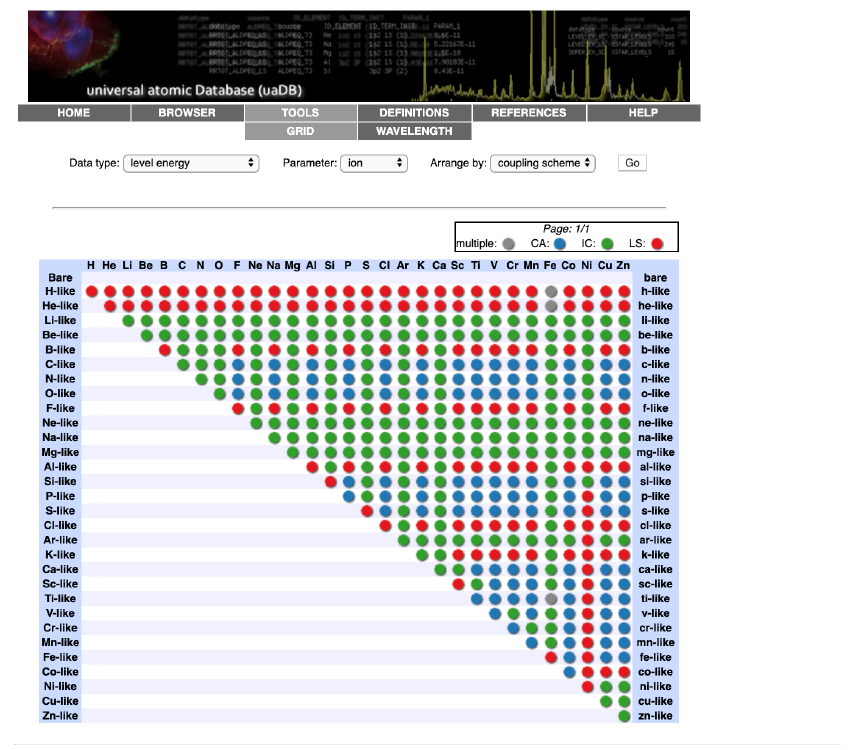
Figure 11. Grid tool in uaDB